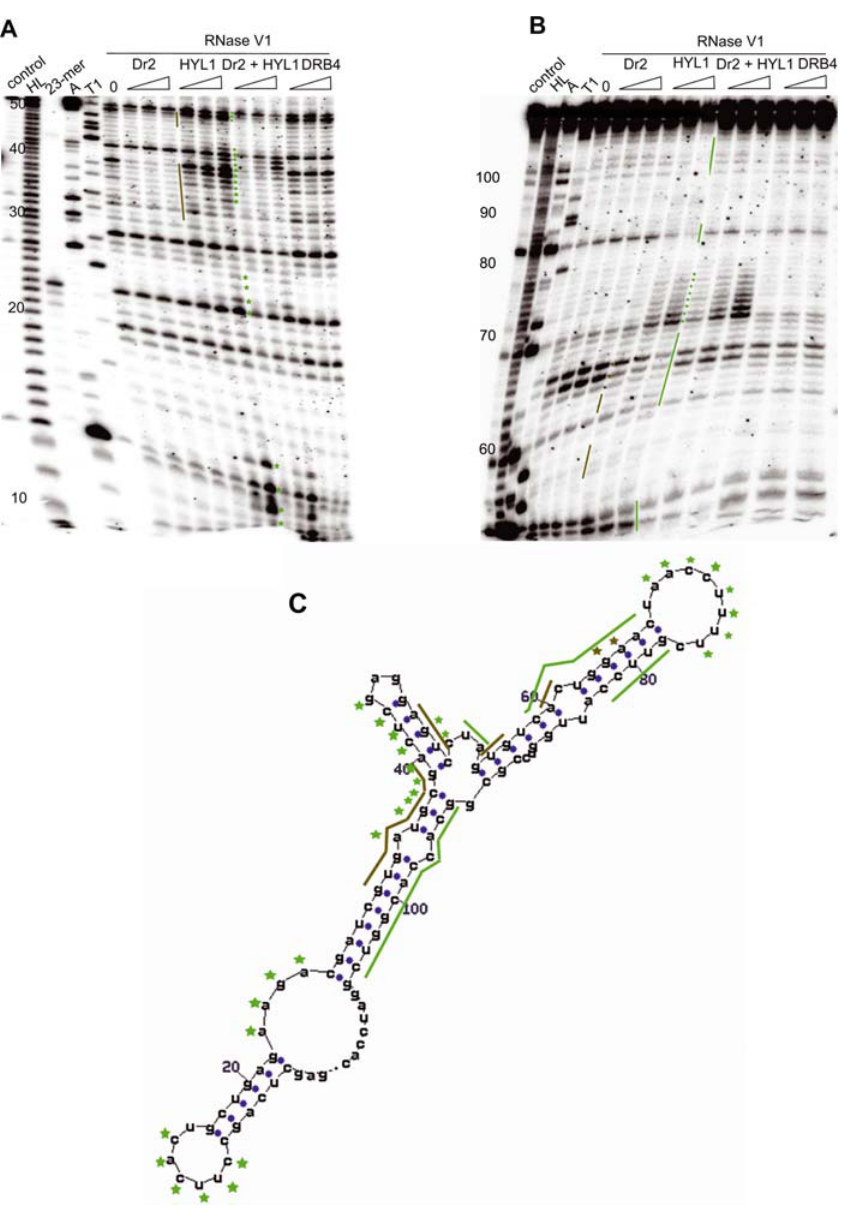
Figure 4. Protection from RNase V1 digestion of SELEX clone 11Dr2(7) by different dsRBPs. Prior to RNase V1 digestion, in vitro transcript of SELEX clone 11Dr2(7) was subjected to protection by increasing concentrations of expressed dsRBPs: Dr2, HYL1, combination of Dr2 and HYL1, or DRB4. Regions protected by Dr2 and HYL1 are marked alongside short run gel (A), long run gel (B) and predicted folding pattern (C) by brown and green bars, respectively. Three independent experiments gave similar results as the one presented. Nucleotides marked with asterisks seem to adopt more prominent helical structure upon protein binding and, therefore, become more prone to RNase V1 cleavage. DRB4 is showing no effect on RNase V1 cleavage of given RNA, confirming its low binding affinity for imperfect RNA duplexes. (HL) represents a partially hydrolyzed RNA ladder. Denaturating RNase A and T1 digests give the position of pyrimidine and G residues respectively. The control lane shows untreated RNA samples and the (0) lane represent RNase V1 digestion without recombinant proteins added. A labeled 23-mer oligoribonucleotide was also loaded on the gel to help in band size determination.